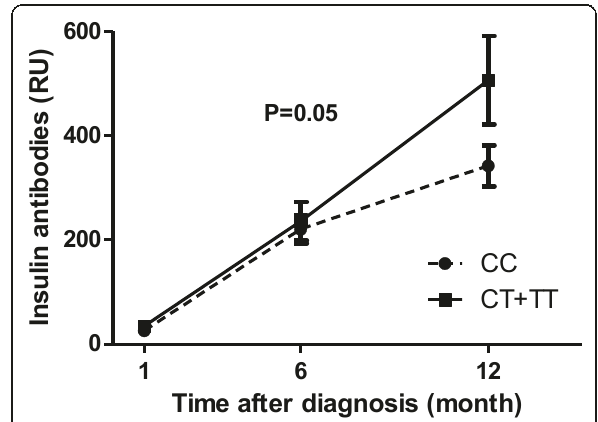
Figure 2 Insulin antibodies over time according to PTPN22 genotypes . Distribution of insulin antibodies (IA) by PTPN22 genotype ((CT+TT) (n = 71) carriers of the variant versus wildtype (CC) (n = 186)) 12 months after disease onset. Mean values (pmol/l) ±